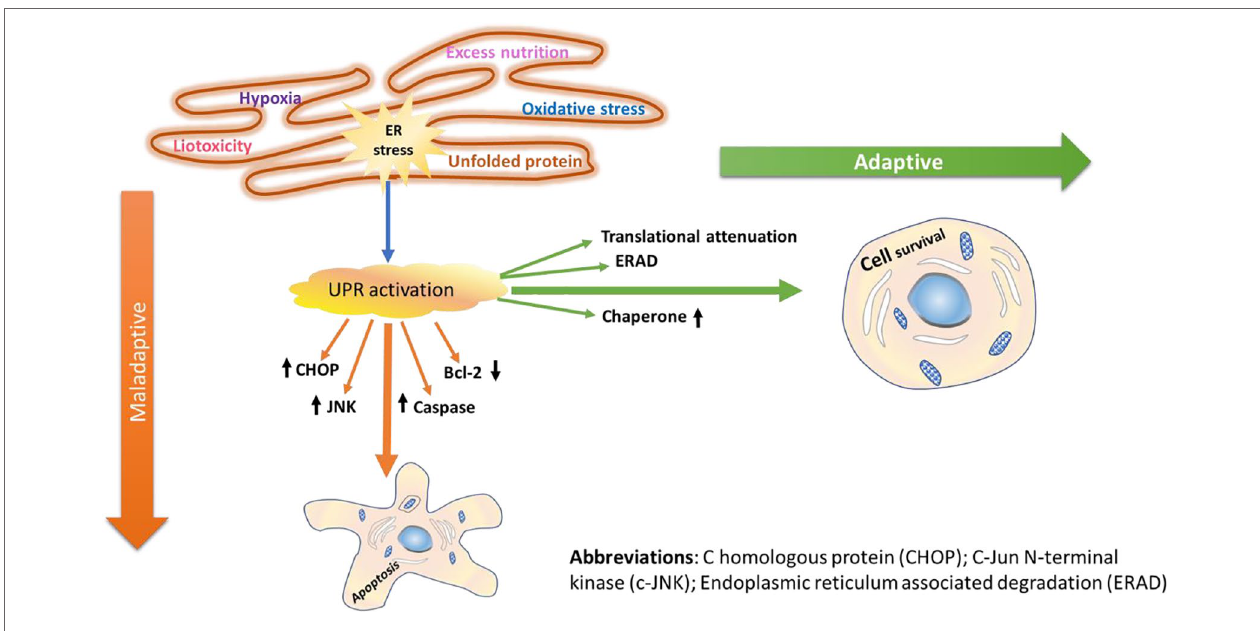
FIGURE 1 | Adaptive and maladaptive mechanisms of UPR signaling. Following the onset of ERS in the cardiac system, cardiac-specific UPR is activated, and the three branches of signaling transducers (PERK, IRE1, and ATF6) are activated. Furthermore, downstream of the three UPR signaling pathways, transcription factors are also activated, and unfolded protein response (UPR) associated genes are upregulated. In general, activation of the UPR signaling networks initiates attenuation of the global protein translation, synthesis of folding chaperones and enzymes, and ERAD of misfolded/unfolded proteins in the ER lumen. Thus, through coordinated attenuation of global protein synthesis, upregulation of ER-resident chaperones, and activation of ERAD, the UPR often manages to resolve/restore acute homeostasis imbalances caused by various stimuli; thus, the cells survive (adaptive mechanism). The primary goal of the UPR activation is to avoid damages caused by the ERS through its adaptive functional role, which reestablishes the ER homeostasis, enhancing cell survival. However, intense ERS makes the cells succumb to apoptosis death (maladaptive mechanism). Once the ERS turns out to be persistent, transcription factors including CHOP, JNK, and caspases are activated, and members of the Bcl family such as Bcl-2 are suppressed, thereby eliciting programmed cell